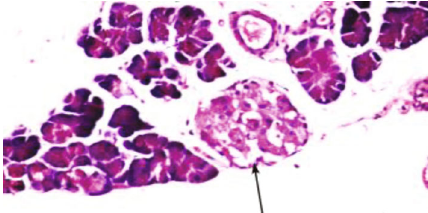
Figure 8: Photomicrograph of pancreatic tissue of L. sativum (100mg/kg BW)-treated animal showing pancreatic islet (arrow) with severe vacuolation in between cells and hypocellularity (H&E) ( ×